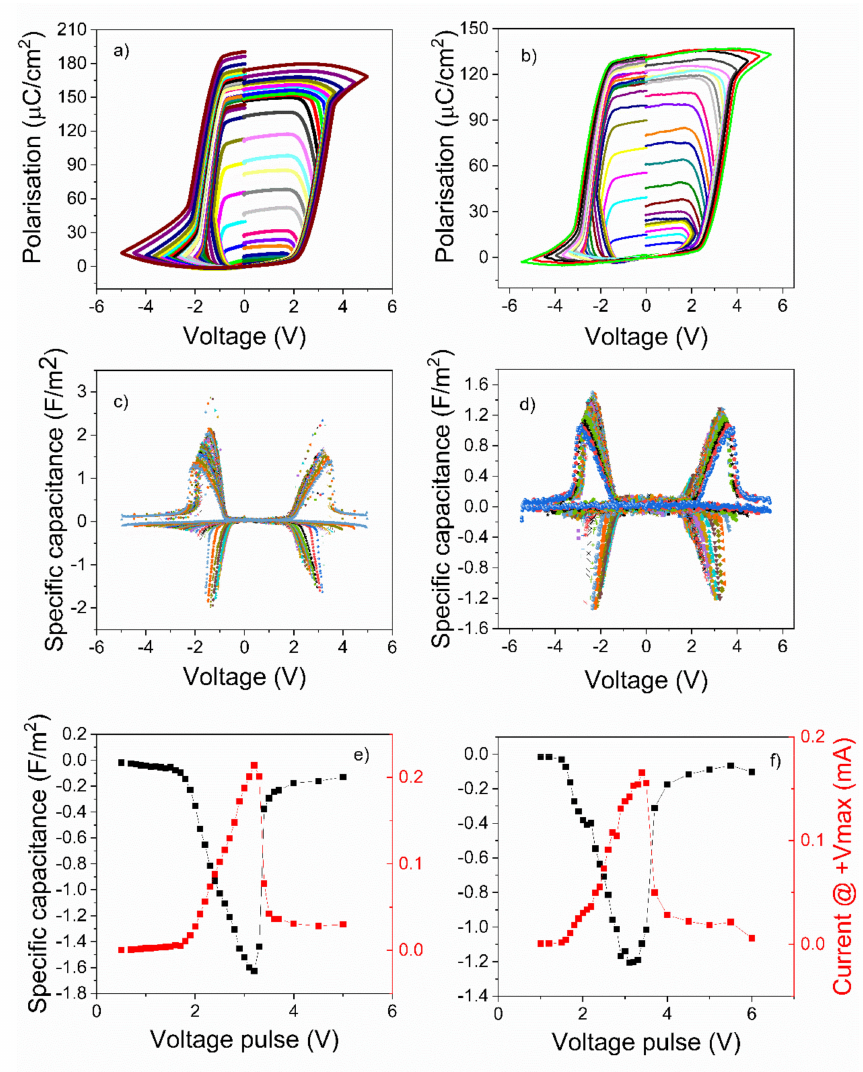
Figure 3. ( a , b ) Polarization-voltage characteristics obtained for different amplitudes of the volt- age pulse. ( c , d ) Specific capacitance obtained from the derivative of polarization-voltage loops. ( e , f ) Representation of the maximum values of the specific capacitance and of the current at maxi- mum voltage as a function of amplitude of the voltage pulses. The results from the first column are at- tributed to the epitaxial PZT thin films deposited from commercial target and the results from the sec- ond column are attributed to the epitaxial PZT thin films deposited from “pure” target,